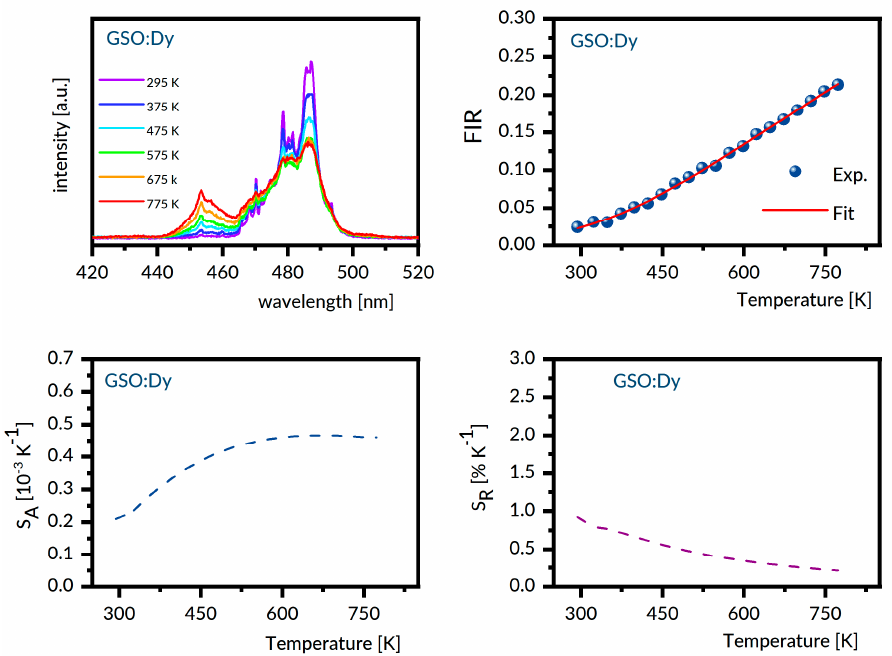
Figure 9. GSO:Dy emission spectra recorded at several different temperatures ( upper left ), the plot of FIR versus temperature ( upper right ), the temperature dependence of S A ( lower left ), and the temperature dependence of S R ( lower right ).